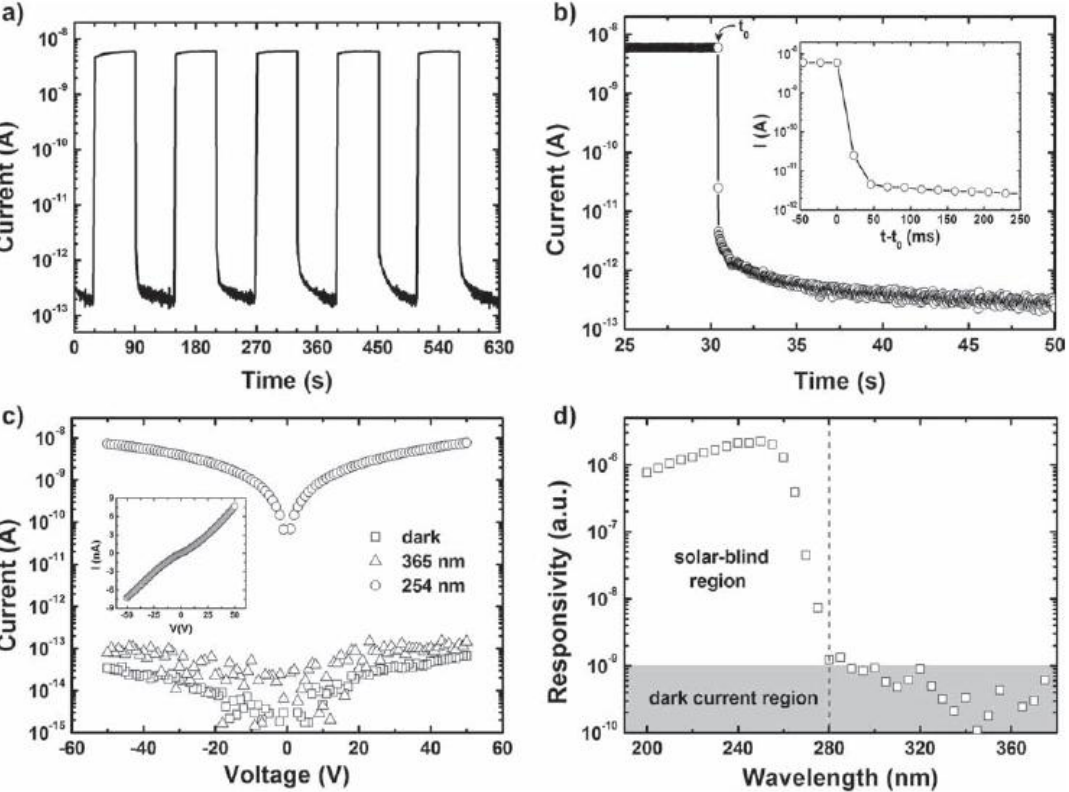
Figure 17. Photoresponse properties of the bridged β -Ga photoresponse measured in the air under 254 nm illumination; ( b ) Photocurrent decay process of the device; ( c ) I-V characteristics of the device in the dark, under 365 nm and 254 nm light illumination; ( d ) Spectral response of the bridged β -Ga revealing that the device is blind to solar light (reprinted from Reference